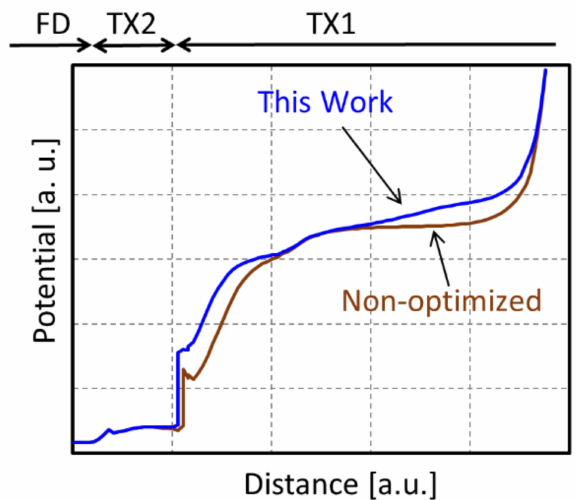
Figure 5. One-dimensional potential profile of the non-optimized MN and the well-designed MN.